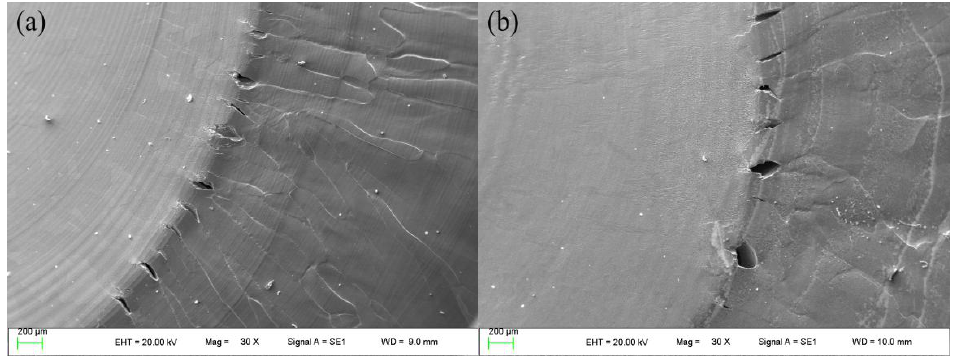
Figure 3. Crack distributions and morphologies under 5% strain for ( a ) 441 and ( b ) 441Ce type materials.